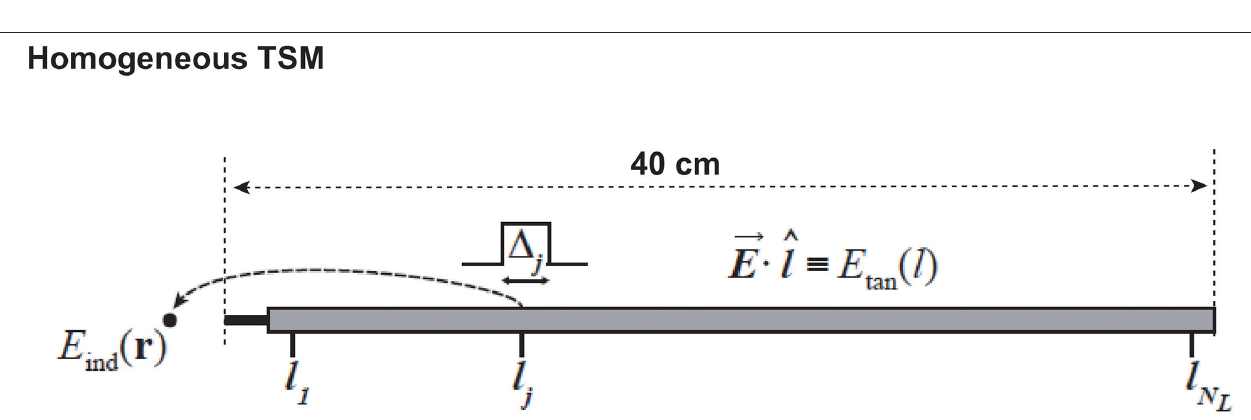
FIGURE 3 | Schematic of the transfer function derived method. l is the unit tangential vector along the implant at length l .